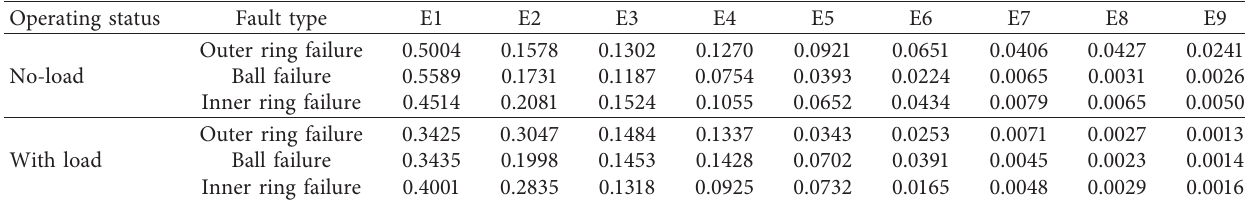
Table 2: Energy normalization results of dual-LMD